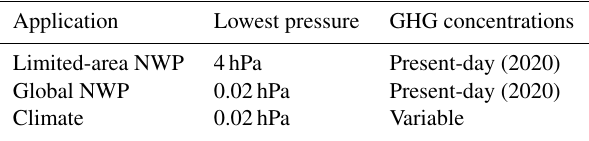
Table 1. The three modelling applications of radiation schemes that we envisage would need to be targeted by a different CKD model. The present-day and “variable” well-mixed greenhouse gas (GHG) concentrations for these scenarios are provided in Table 2. Heating- rate calculations by CKD models will be evaluated at pressures down to the indicated “lowest pressure”, although note that the ref- erence LBL calculations are performed down to lower pressures than